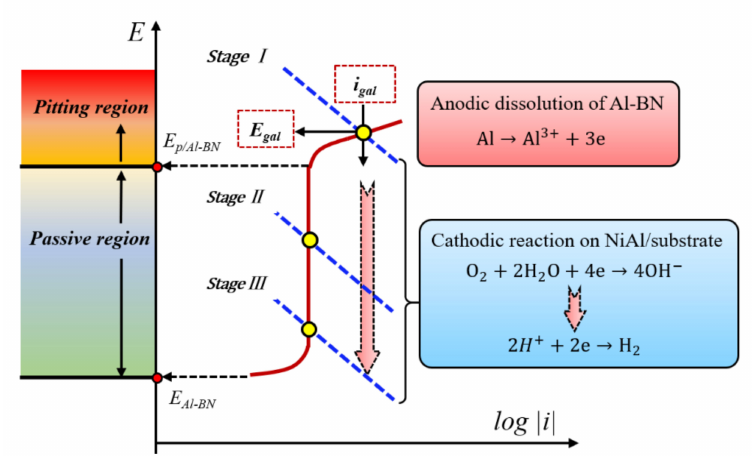
Figure 13. Schematic diagram about changes of the galvanic potential based on mixed potential theory.